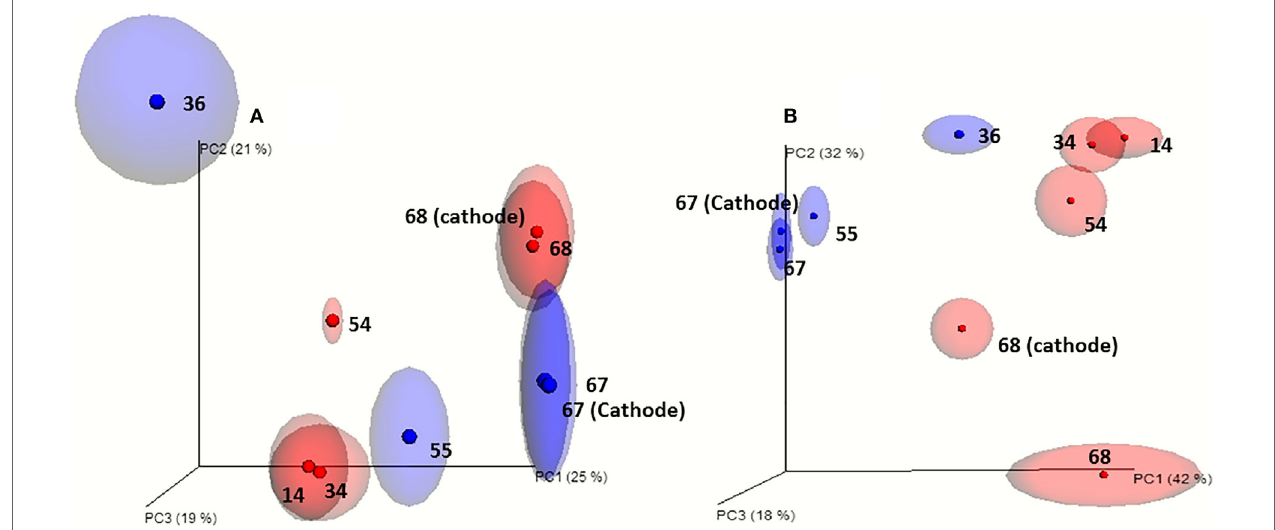
FigUre 2 | Beta diversity analysis of the microbial communities based on the 16S rRNA gene pyrosequencing results. (a) Jack-knifed (even 500) unweighted- UniFrac and principal component analysis. (B) Jack-knifed (even 500) weighted-UniFrac and principal component analysis. Ellipses indicates the dispersion obtained for the Jack-knife analysis (red: cell A; blue: cell B). The samples obtained from the bulk solution are indicated by the day of sampling and the samples taken from the biofilm of the cathodes at the end of the experiments are indicated by the day of sampling and the word